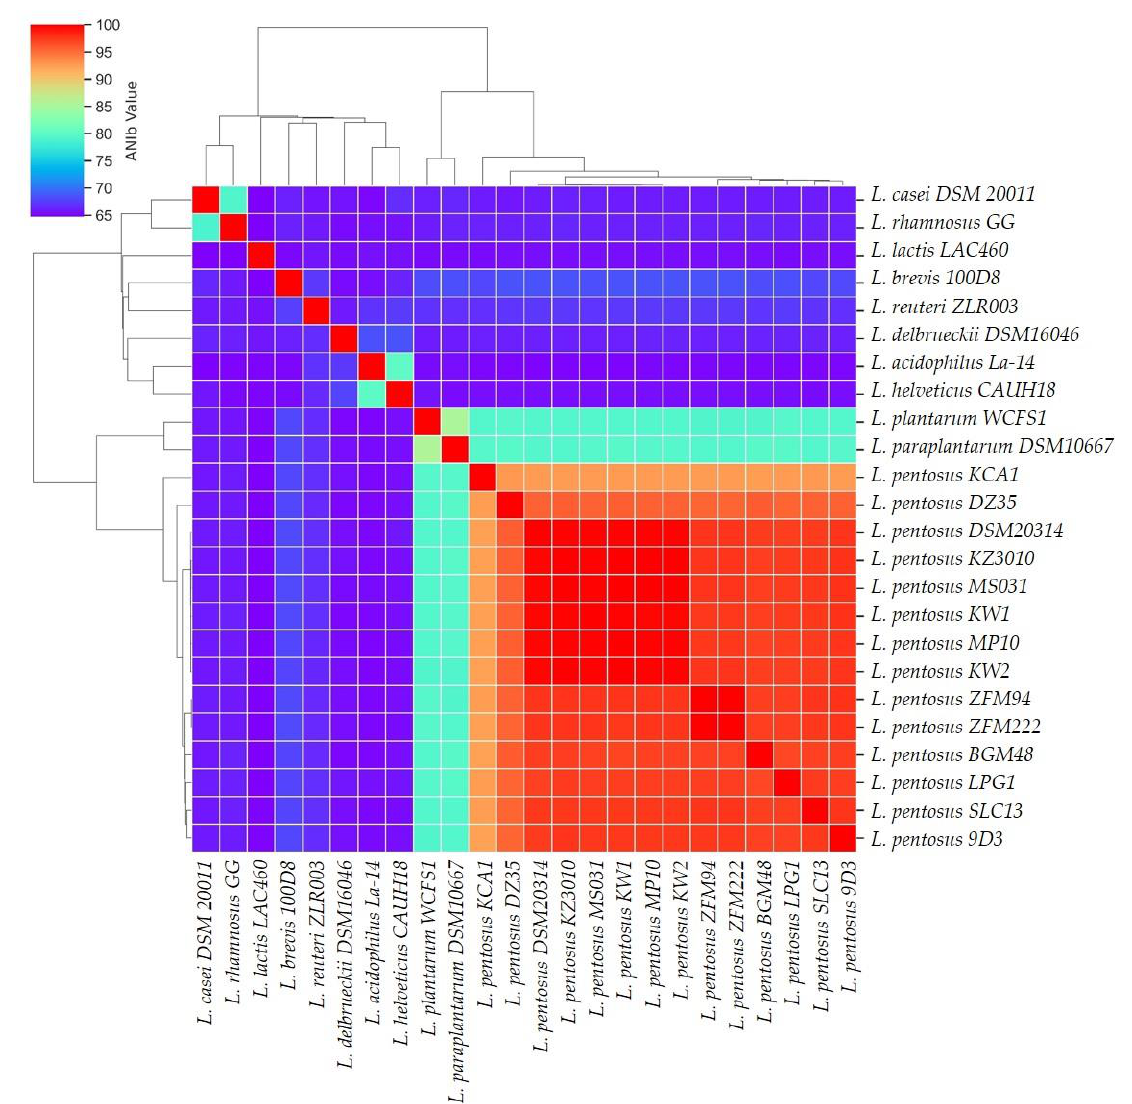
Figure 3. Taxonomy hierarchical clustering and heat map of ANI (average nucleotide identity) analysis included different strains of the L. pentosus , L. plantarum , and L. paraplantarum species, as well as other genera from the Lactobacillaceae family.